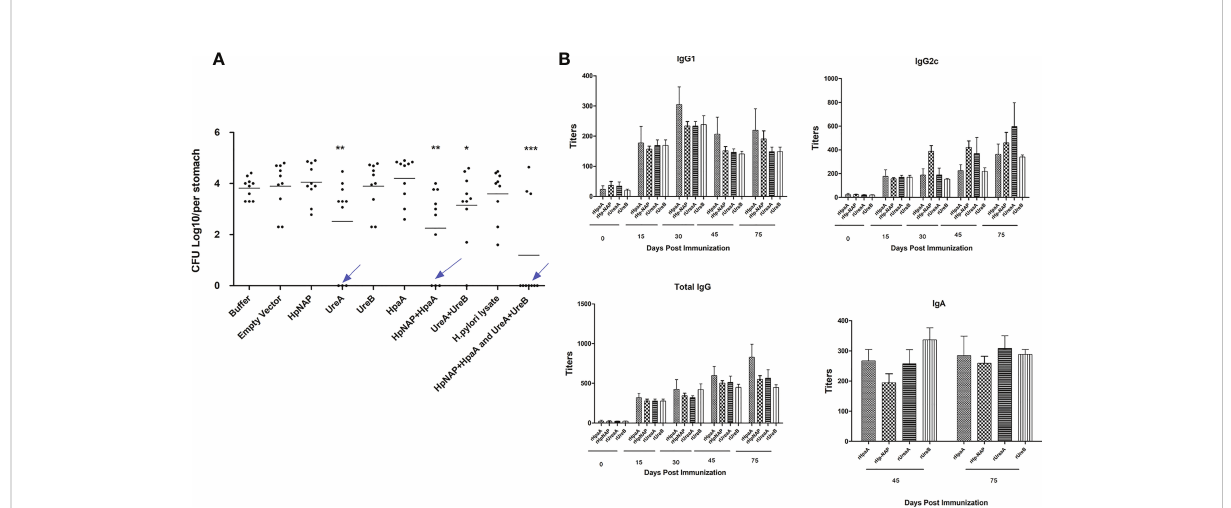
FIGURE 2 (A) Protection against ( H ) pylori SS1 challenge infection following oral vaccination of mice with individual and combinations of c 12341 strains harboring plasmids listed in Table 1 synthesizing and delivering speci fi ed ( H ) pylori antigens. (B) Speci fi c antibody responses in immunized animals. Kinetics of speci fi c antibody responses after oral immunization with a cocktail vaccine of c 12341(pG8R230) and c 12341(pG8R262) delivering UreA and UreB and NapA and HpaA, respectively. Mice were bled (submandibular bleeding method) on the indicated days, and speci fi c IgG1 and IgG2c and total IgG antibody titers against recombinant UreA, UreB, NapA and HpaA evaluated by ELISA. Titer values represent the mean ± SD of sera from three analyses of fi ve animals each. Stomach suspensions were obtained 45 days post fi rst immunizationand speci fi c IgA titers were analyzed by